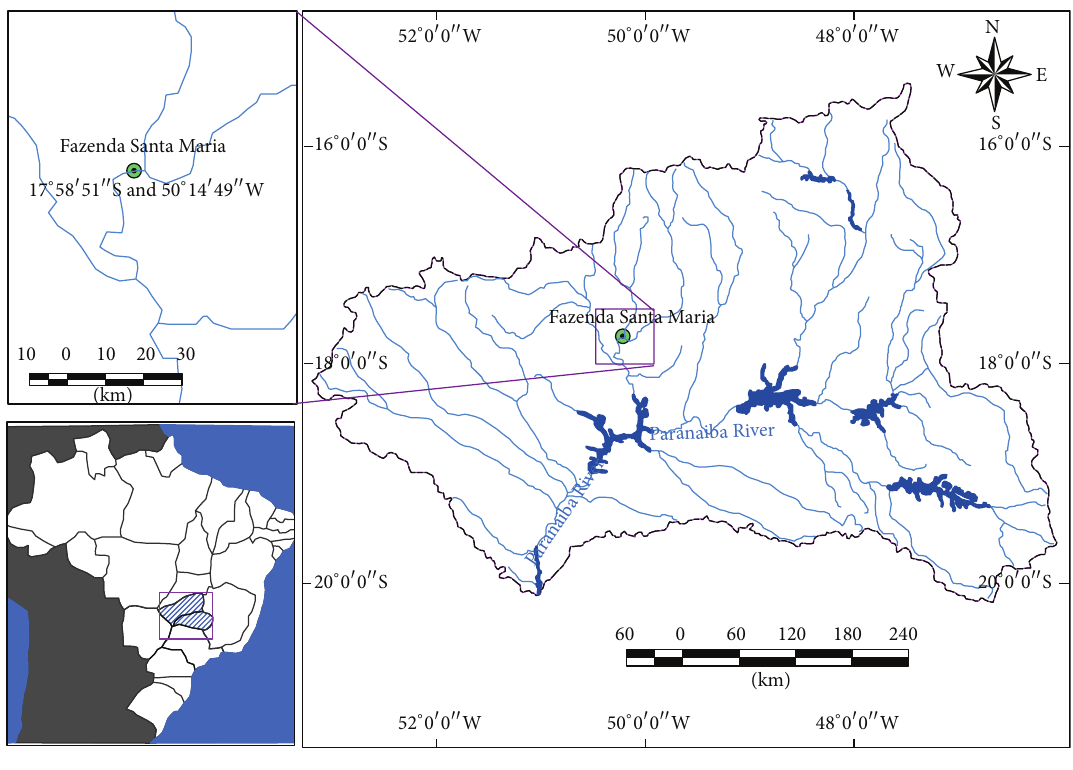
Figure 1: The Paranaiba River basin with Fazenda Santa Maria (green mark) gauge